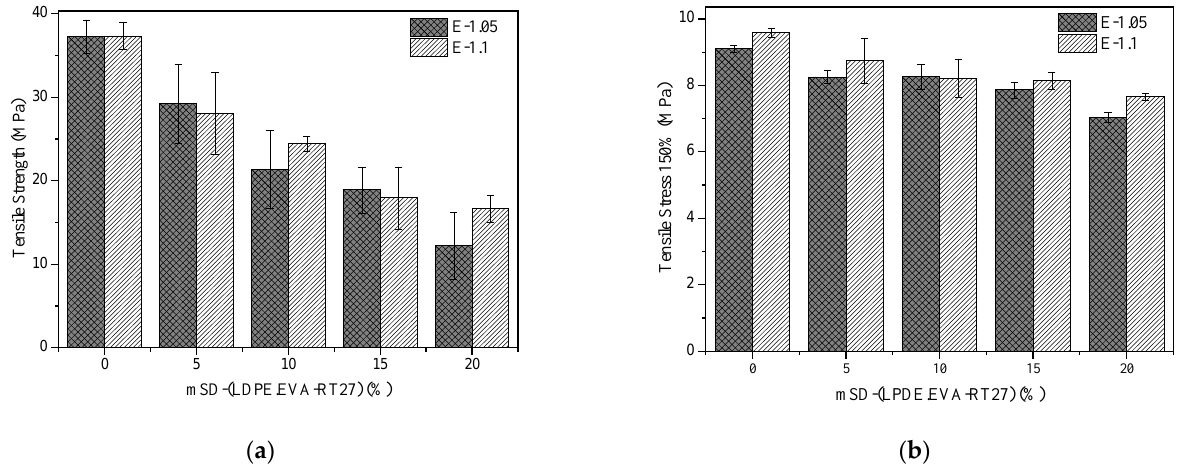
Figure 8. The tensile strength at break ( a ) and tensile stress at a deformation of 150% ( b ). A reduction of both properties when the mSD-(LDPE · EVA-RT27) microcapsules were added can be observed, especially for E-1.05-20. This decrease could be caused by the elastomer heterogeneity promoted by worse microcapsule distribution, which favors the fractured appearance. On the other hand, elastomer E-1.1 presented better results than E-1.05 in the case of tensile stress at a deformation of 150%, suggesting greater rigidity of E-1.1, while the tensile strength results were very similar.